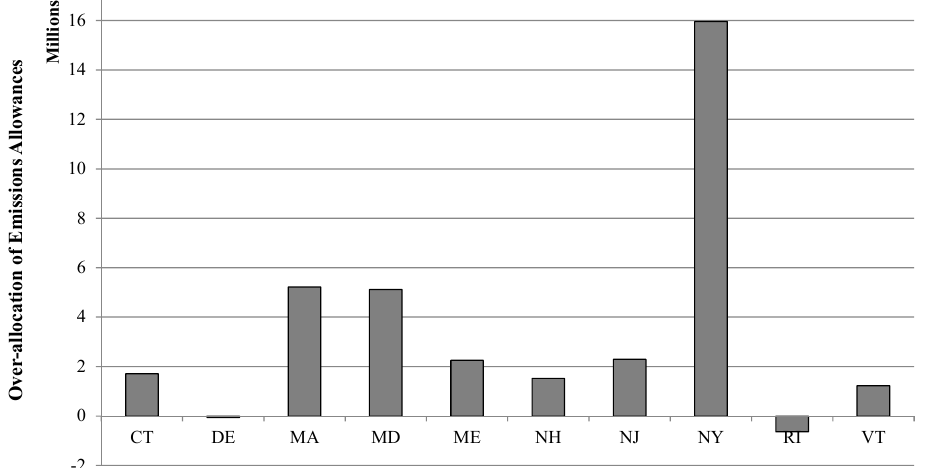
Figure 1. Government over-allocation of emissions allowances in the New England carbon market (Note: Values in Figure 1 are the state by state difference between reported 2008 emissions from the Regional Greenhouse Gas Initiative (RGGI) carbon inventory and state final allowance allocations (issued allowances); Over-Allocation = Allowances Issued—2008 Emissions Inventory .). CT: Connecticut; DE: Delaware; MA: Massachusetts; MD: Maryland; ME: Maine; NH: New Hampshire; NJ: New Jersey; NY: New York; RI: Rhode Island; VT: Vermont.